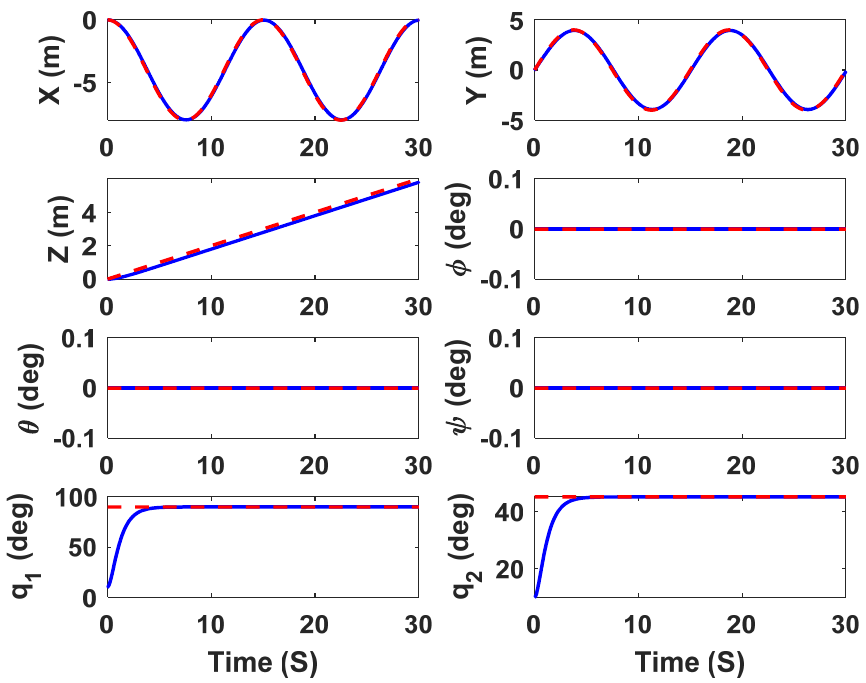
Figure 5. States of ACMS for the first control case (reference: red).